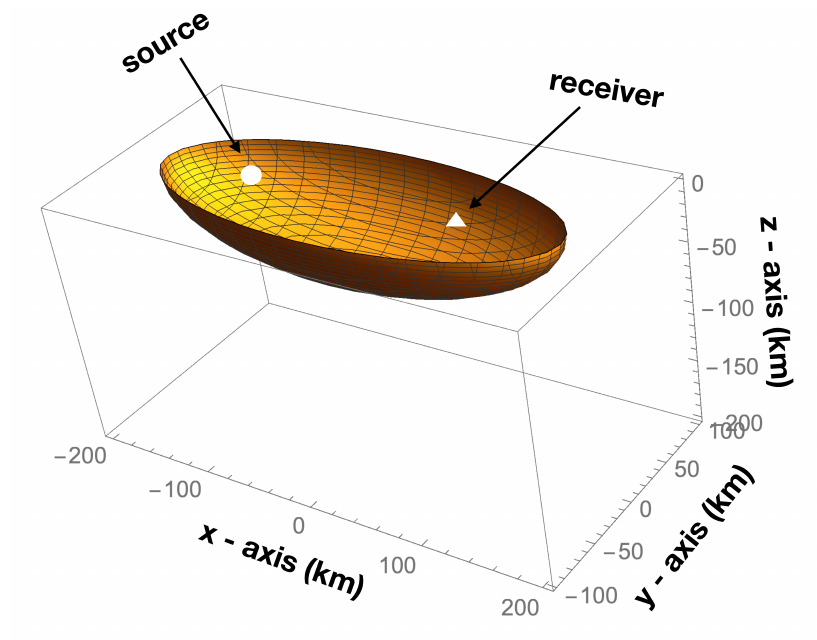
Figure 2. Scattering ellipsoid in case of surface source and receiver, at a distance of 230 km for max lapse time of 100